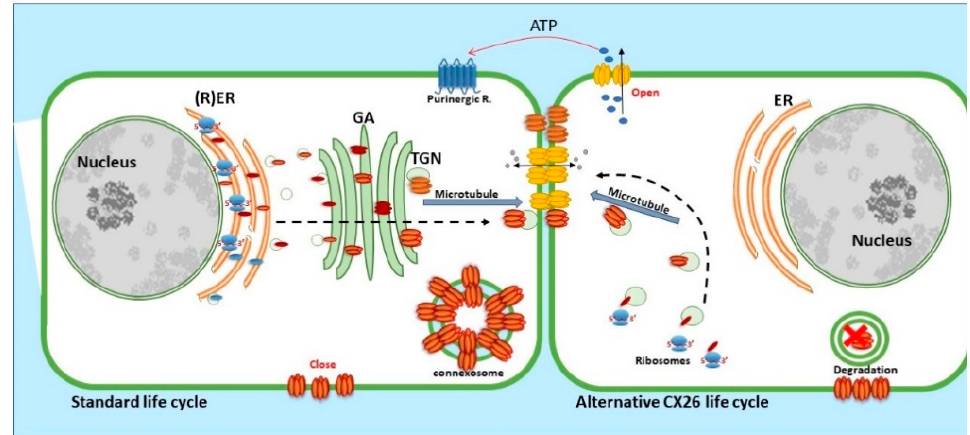
Figure 3. Life cycle of CX26: CX26 can be co-translated and trafficked through the secretory route (standard life cycle). It can also be post-translationally incorporated into ER microsomes and trafficked by Golgi-independent pathway (alternative CX26 life cycle). GJIC mediated communication is indicated between cells and paracrine signalling permitting ATP release indicated via the open hemichannels.